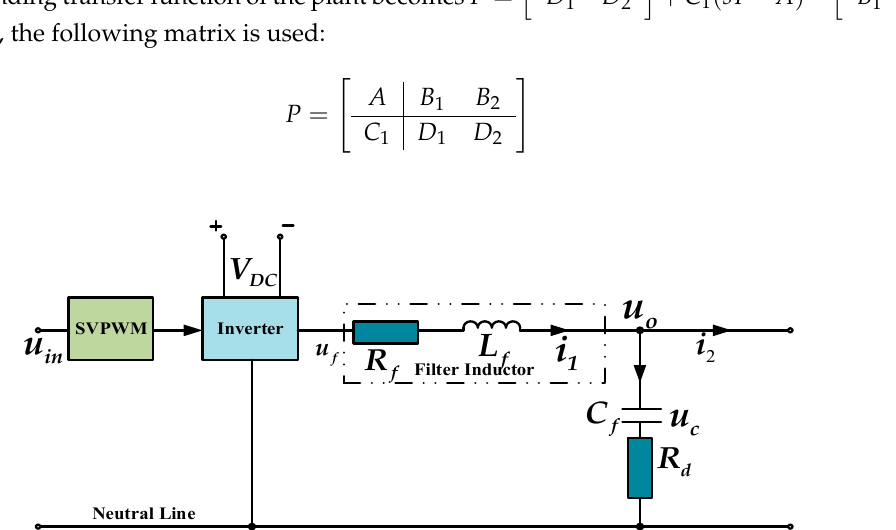
Figure 3. Sketch of a single-phase inverter.